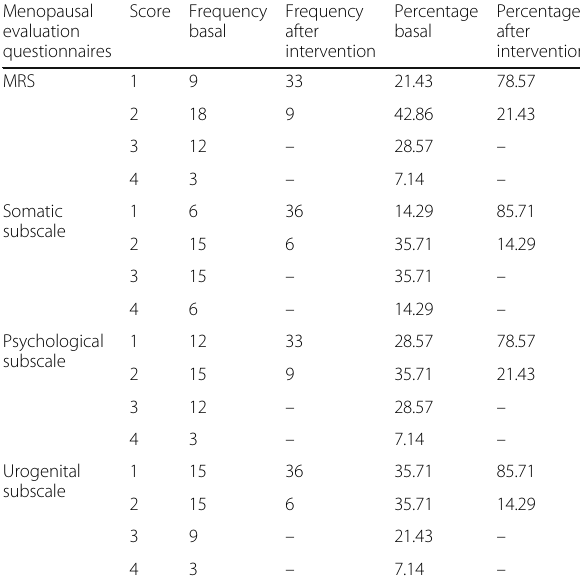
Table 4 Frequency and percentage of menopausal symptoms score before and after blend consumption (no.